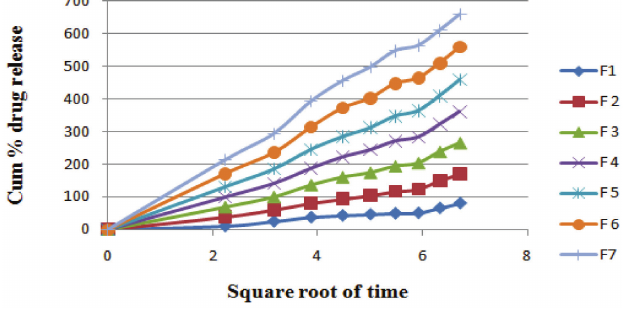
FIGURE 4 - Higuchi model plot.